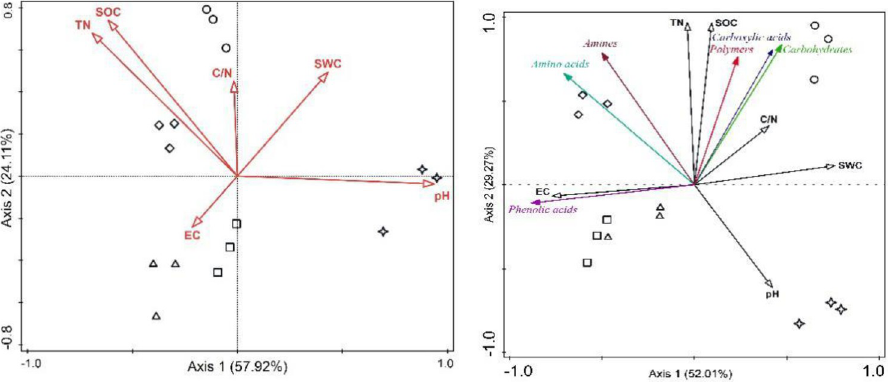
Fig 5. RDA based on AWCD and soil properties (left) and six carbon source utilization and soil properties(right) among different extract concentration treatments. Symbols indicate concentrations (circle: 0 g ‧ mL -1 , triangle: 2.5 mg ‧ mL -1 , diamond: 5 mg ‧ mL -1 , square: 7.5 mg ‧ mL -1 , star: 10 mg ‧ mL -1 ). SWC: soil water content, EC: electrical conductivity, TN: total nitrogen, SOC: soil organic carbon and C/N: C: N